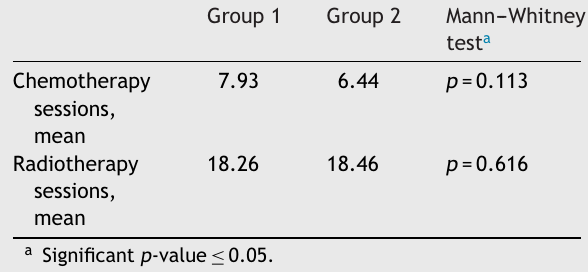
Distribution of oncology treatment sessions in the studied population (n = 58).